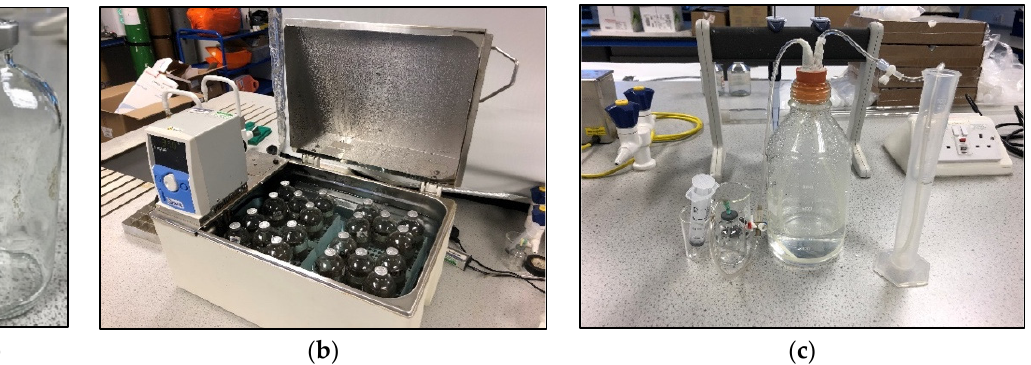
Figure 3. BHP equipment and material. ( a ) Wheaton bottle (160 mL), ( b ) water bath 37 °C, ( c ) water- displacement device.